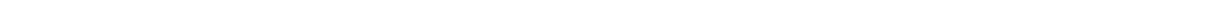
Fig. 6 Results of a large-scale intact N-glycopeptide analysis of mouse tissues. a Precursor mass deviation of 79,930 GPSMs. b Retention times of 61 different glycopeptides with the same peptide backbone ‘ NLSYEAAPDHK ’ . The x -axis represents the window of retention time, the y-axis represents the log10 (intensity), and each color represents a different glycopeptide. c Example of a chimera spectrum from multiple glycopeptides. pGlyco 2.0 identi fi ed two different glycopeptides in one spectrum, illustrated in the form of a mirrored spectral annotation. The top and bottom spectra in each fi gure are the same spectrum with different glycopeptide identi fi cations. The design of the annotation in each spectrum is the same as that in Fig. 1. d The MS1 data corresponds to the chimera